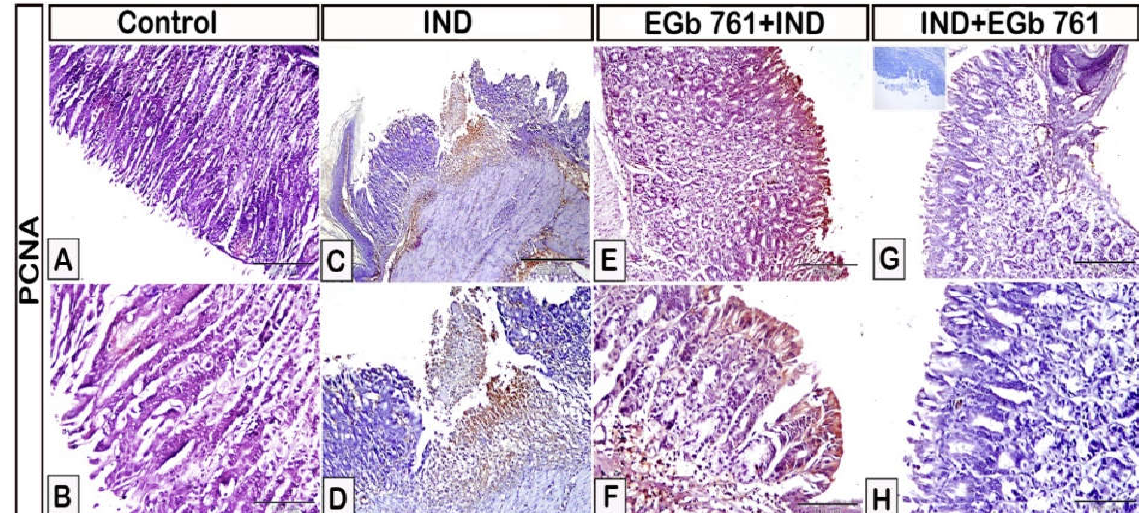
Figure 8. Immunohistochemical presentation of gastric tissue samples illustrating the effect of ad- ministration of indomethacin and EGb 761 on the expression levels of IL-6. ( A – D ): Control mice. (E- H): Indomethacin-induced ulcer (IND). ( I – L ): EGb 761 +IND (Prophylactic EGb 761). ( M – P ): IND+EGb 761 (Therapeutic EGb 761). Negative marker control is shown in the inset of Figure 8A. IND: Indomethacin; EGb 761: Standardized G. biloba extract; IL-6: Interleukin-6.